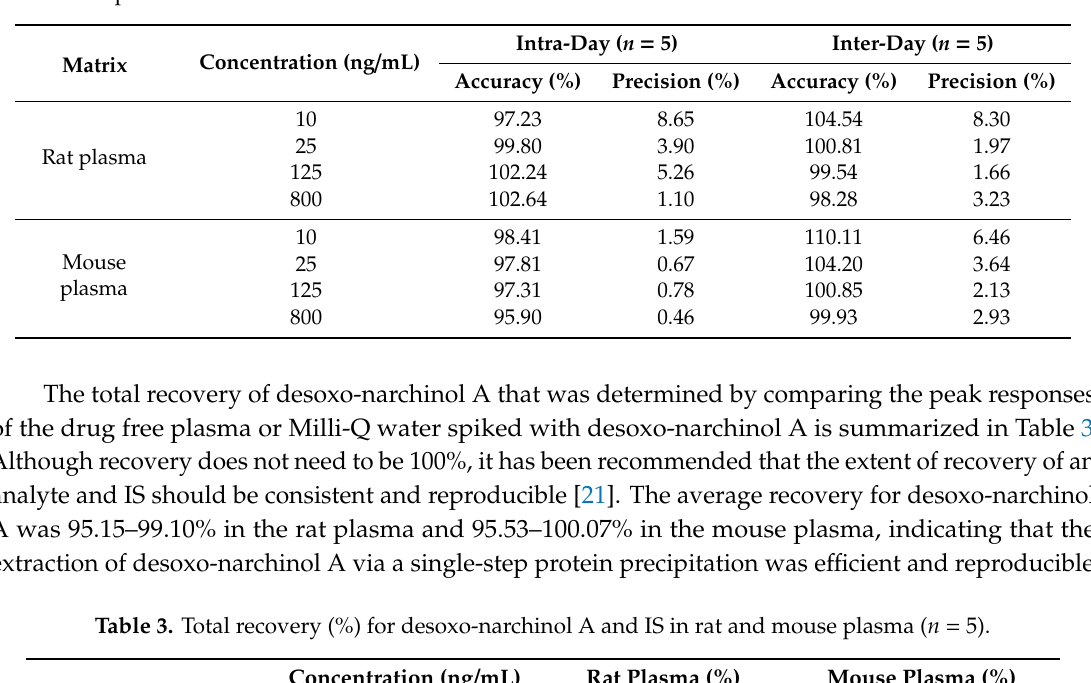
Table 2. Intra- and inter-day accuracy and precision of desoxo-narchinol A assay in rat and mouse plasma.